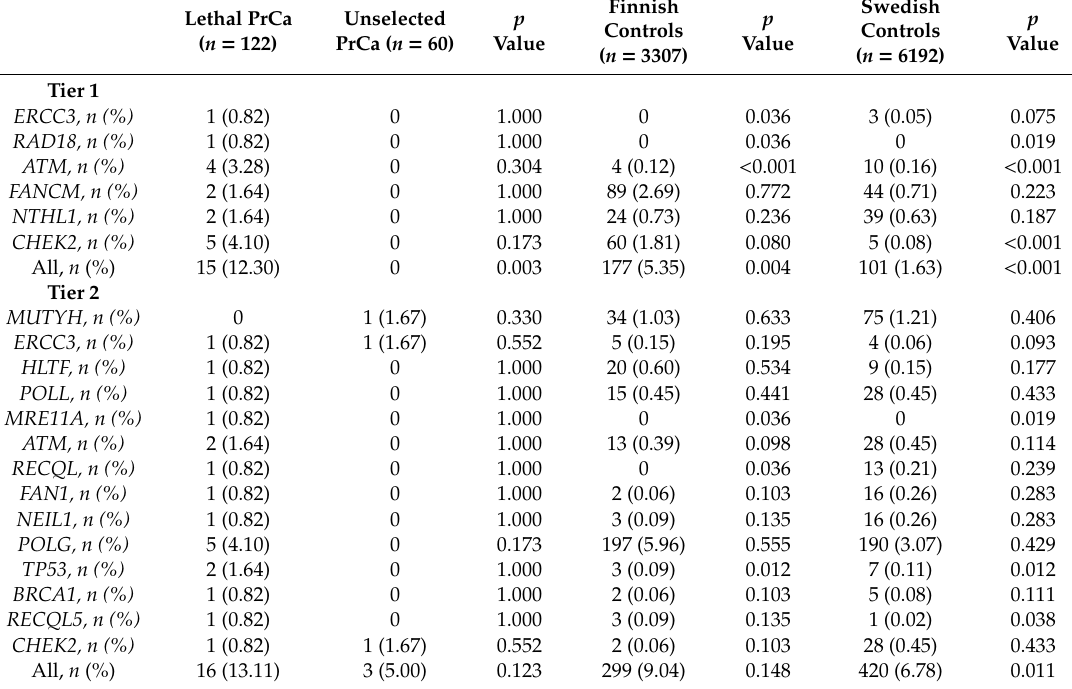
Table 3. Carrier rates of potentially damaging mutations, stratified by Tier 1 and Tier 2 classification, in men with lethal prostate cancer, unselected prostate cancer, and population